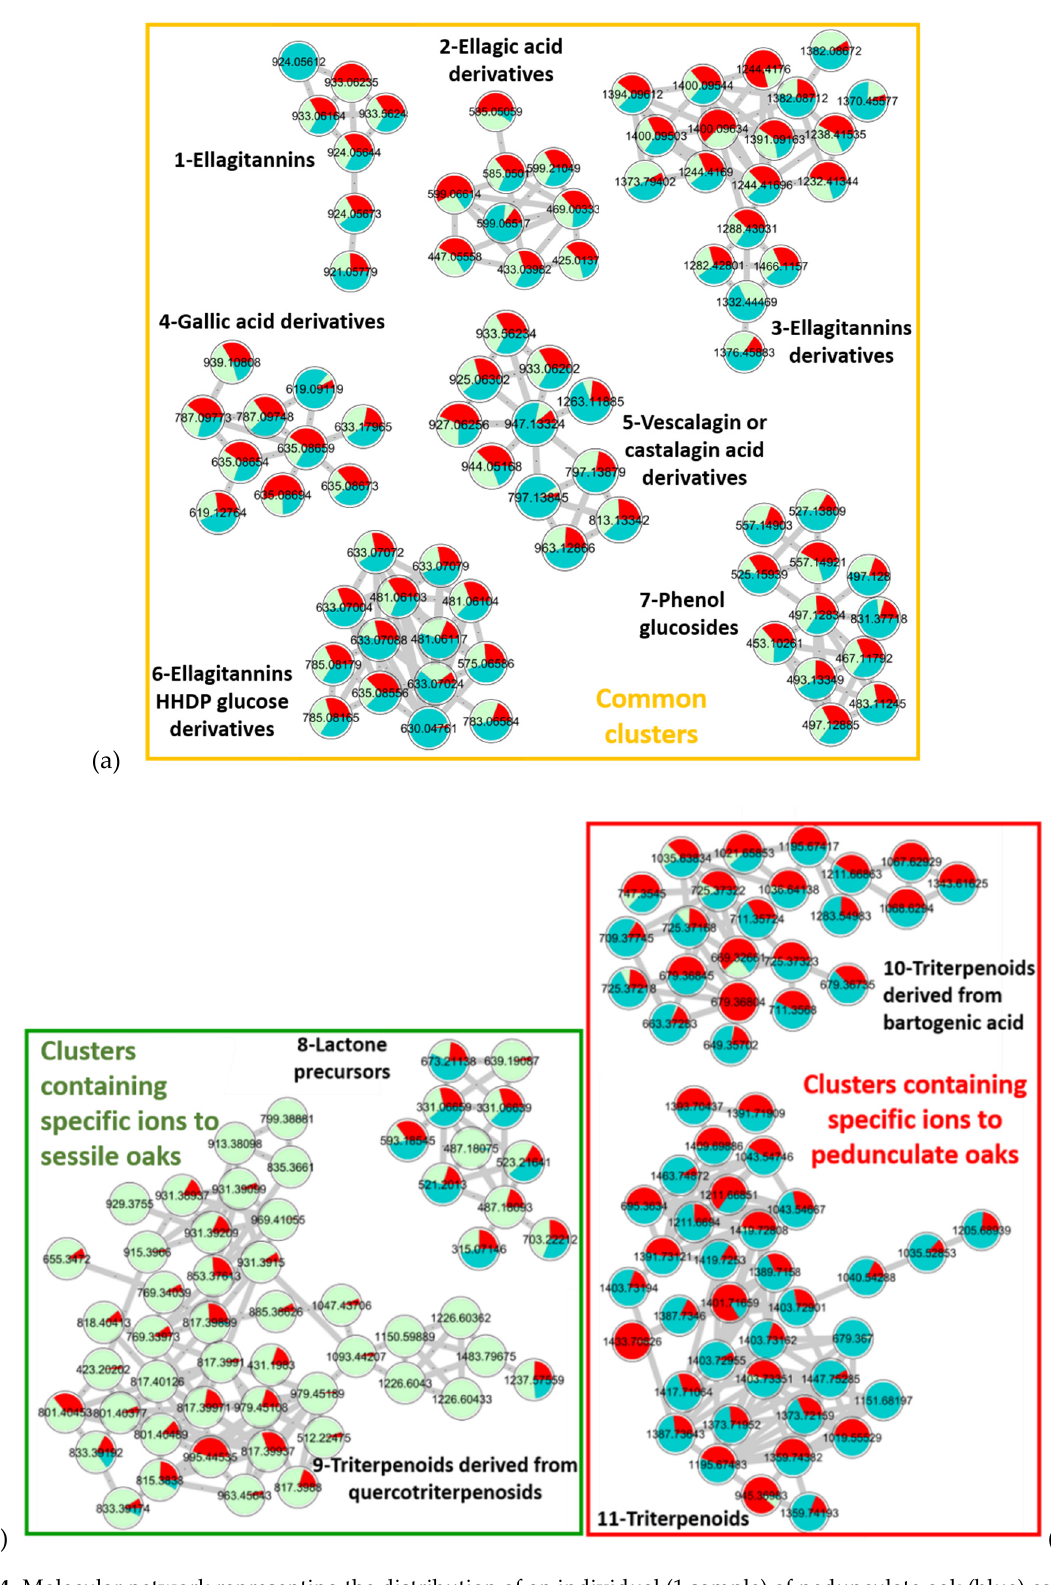
Figure 4. Molecular network representing the distribution of an individual (1 sample) of pedunculate oak (blue) compared to the pool (21 samples) of sessile (green) and (21 samples) pedunculate (red) oaks with cos 0.75 and matched fragment 6 parameters. ( a ) Clusters 1–7 representing common clusters shared between sessile, pedunculated and unknown individual, ( b ) Clusters 8 and 9 containing specific ions to sessile oaks and ( c ) Clusters 10 and 11 containing specific ions to pedunculated oaks shared with unknown